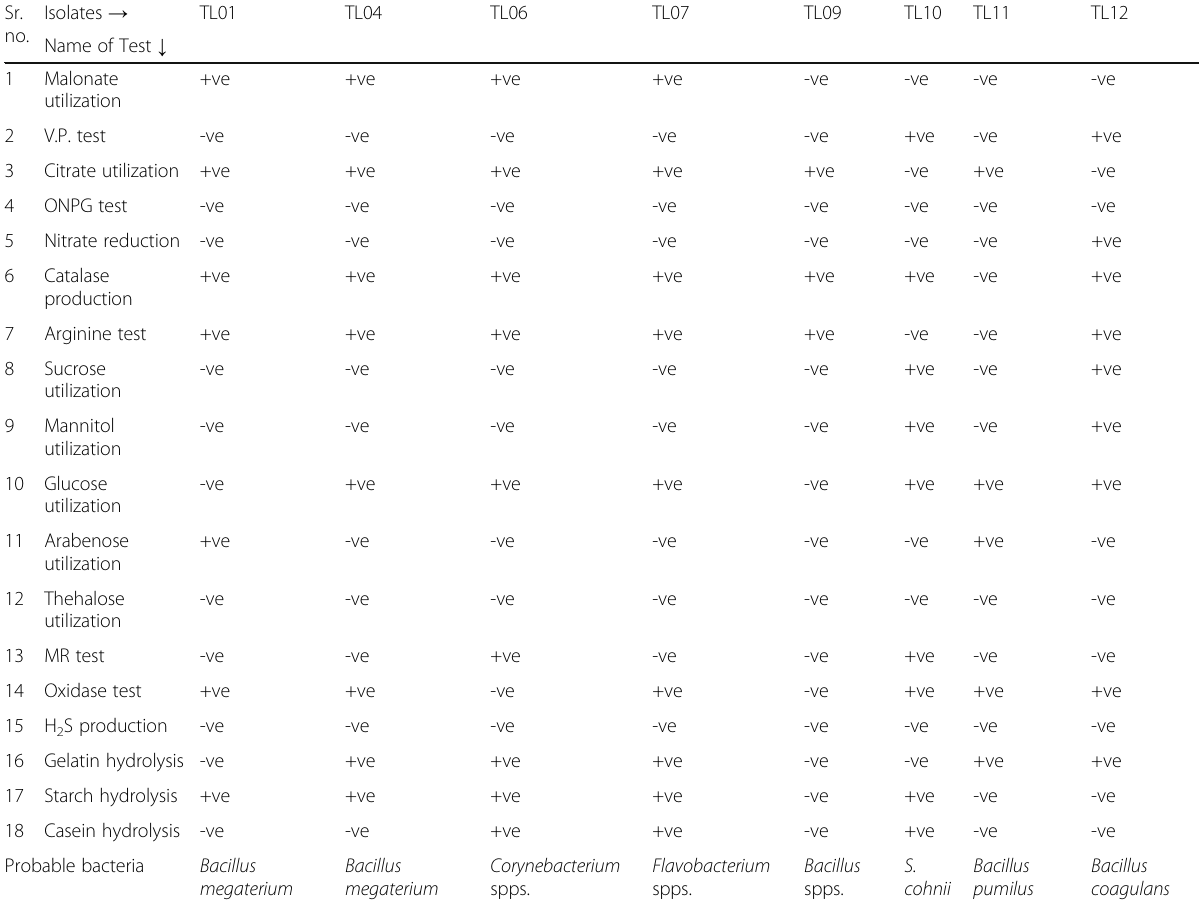
Table 8 Biochemical characterization of used leech Gram-positive isolates Sr. Isolates no.